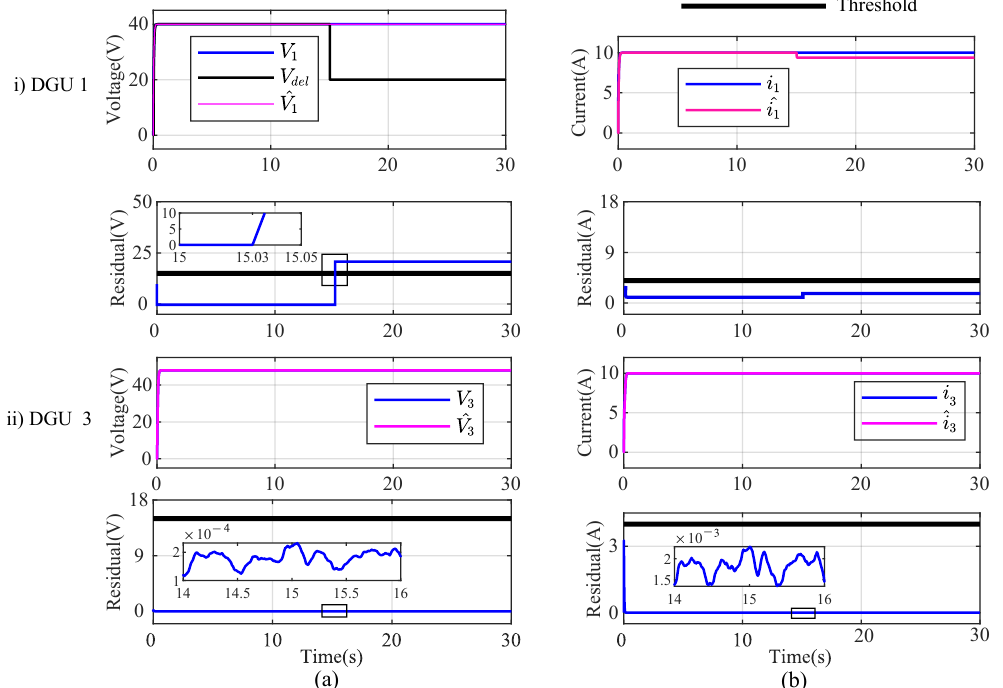
Figure 9. Response of the HOSM observer with delay and a voltage sensor fault in DGU 1 at t = 15 s. ( a ) Voltage residuals of the DGUs; ( b ) Current residuals of the